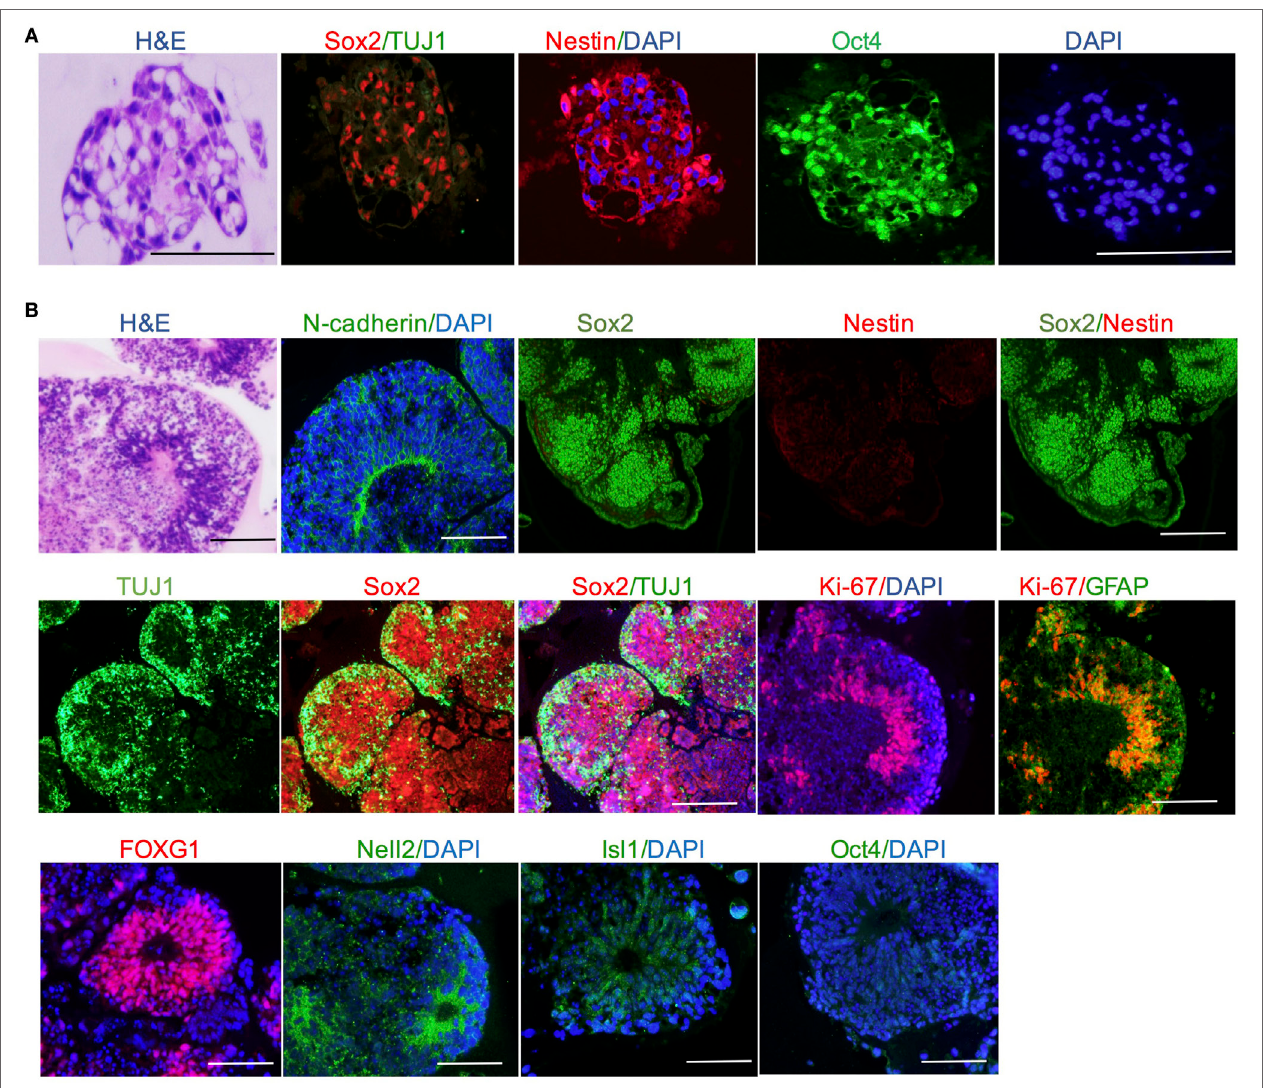
FigUre 2 | Cerebral organoid tissues displayed brain regions and neuronal cell identities. (a) Neuroepithelium at day 11 presents neural precursor differentiation. (B) Cerebral organoids at day 20 presented neural N-cadherin in the apical membrane. Forebrain, hindbrain, and hippocampus regions of an organoid stained positive by FOXG1, Nell2, and Isl1 markers, respectively. Neuron-specific cells neurons and glial cells were marked by TUJ1 and GFAP, respectively. Pluripotency markers Oct4 disappeared in mature cerebral organoids. Scale bars: 200